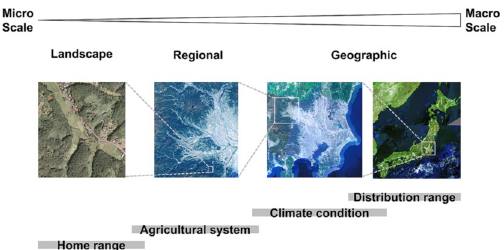
Figure 1. Multi-scale hierarchical structure of agricultural landscapes. The aerial photographs in the figure have been created by processing the latest seamless aerial photographs of Japan obtained from the GSI map produced by Geospatial Information Authority of Japan (https:// maps. gsi. go.